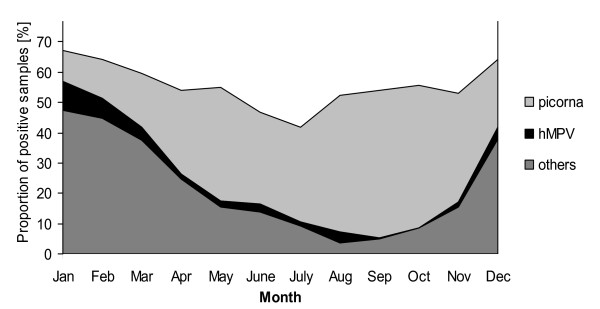
Mean monthly distribution of respiratory viruses detected by DFA in nasopharyngeal aspirates from hospitalized children from November 2006 to April 2010. picorna = respiratory picornaviruses; hMPV = human metapneumovirus; others = adenovirus, respiratory syncytial virus, influenza A and B, parainfluenza viruses 1-3.